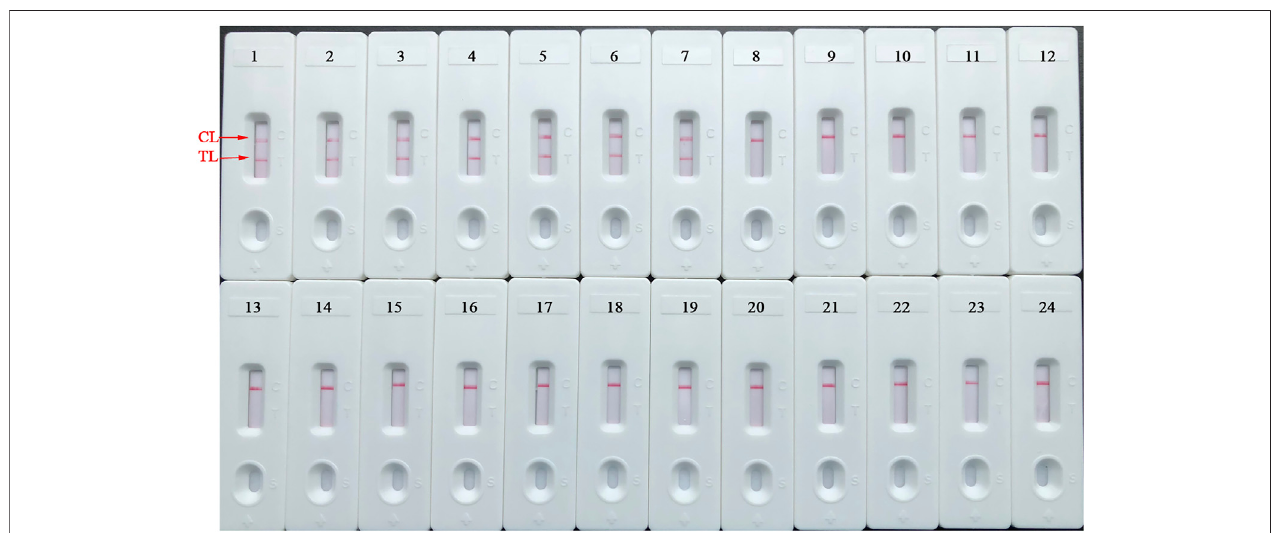
FIGURE 6 | Detection speci fi city of B. abortus -LAMP-LFIA assay for various pathogens. The B. abortus -LAMP tests were performed using template DNA of different pathogens, and the amplicons were veri fi ed by LFIA strips. Strips 1 – 3, B. abortus 544 (ATCC 23448), B. abortus A19, and B. abortus 2038; strips 4 – 7, B. abortus (isolates); strips 8 – 10, B. melitensis 16M (ATCC 23456), B. melitensis M28, and B. melitensis M5; strips 11 – 12, B. melitensis (isolates); strips 13 – 16, B. suis 1330S (ATCC 23444), B. suis S2, B. suis (isolate), and B. canis (isolate); strips 17 – 23, Mycobacterium tuberculosis , Mycobacterium bovis , Listeria monocytogenes , Salmonella spp., Klebsiella pneumoniae , Pseudomonas aeruginosa, and Streptococcus pneumoniae ; strip 24, blank control (ddH 2 O). LAMP, loop- mediated isothermal ampli fi cation; LFIA, lateral fl ow immunoassay biosensor; TL, test line; CL, control line; ddH 2 O, double distilled water; BC, blank control; ATCC,